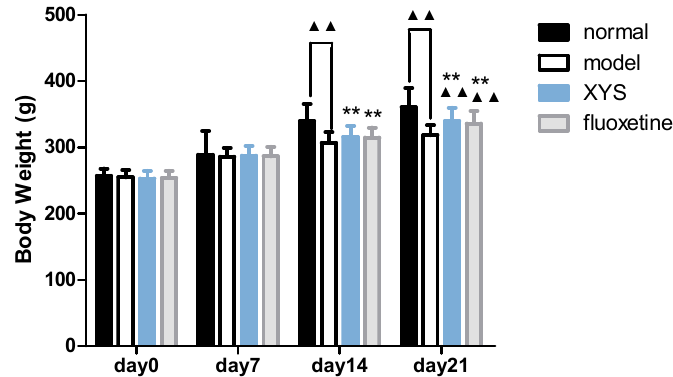
Figure 1. Body weight of each group. The data were expressed as mean ± standard deviation ( x ± s), Figure 1 . Body weight of each group. The data were expressed as mean ± standard deviation ( (cid:1876)̅ ± s), n = 21. ▲▲ p < 0.01, compared with the model group; ** p < 0.01, compared with the normal group. n = 21. (cid:78)(cid:78) p < 0.01, compared with the model group; ** p < 0.01, compared with the normal group. Figure 1 . Body weight of each group. The data were expressed as mean ± standard deviation ( (cid:1876)̅ ± s), n = 21. ▲▲ p < 0.01, compared with the model group; ** p < 0.01, compared with the normal group. Figure 1 . Body weight of each group. The data were expressed as mean ± standard deviation ( (cid:1876)̅ ± s), n = 21. ▲▲ p < 0.01, compared with the model group; ** p < 0.01, compared with the normal group.